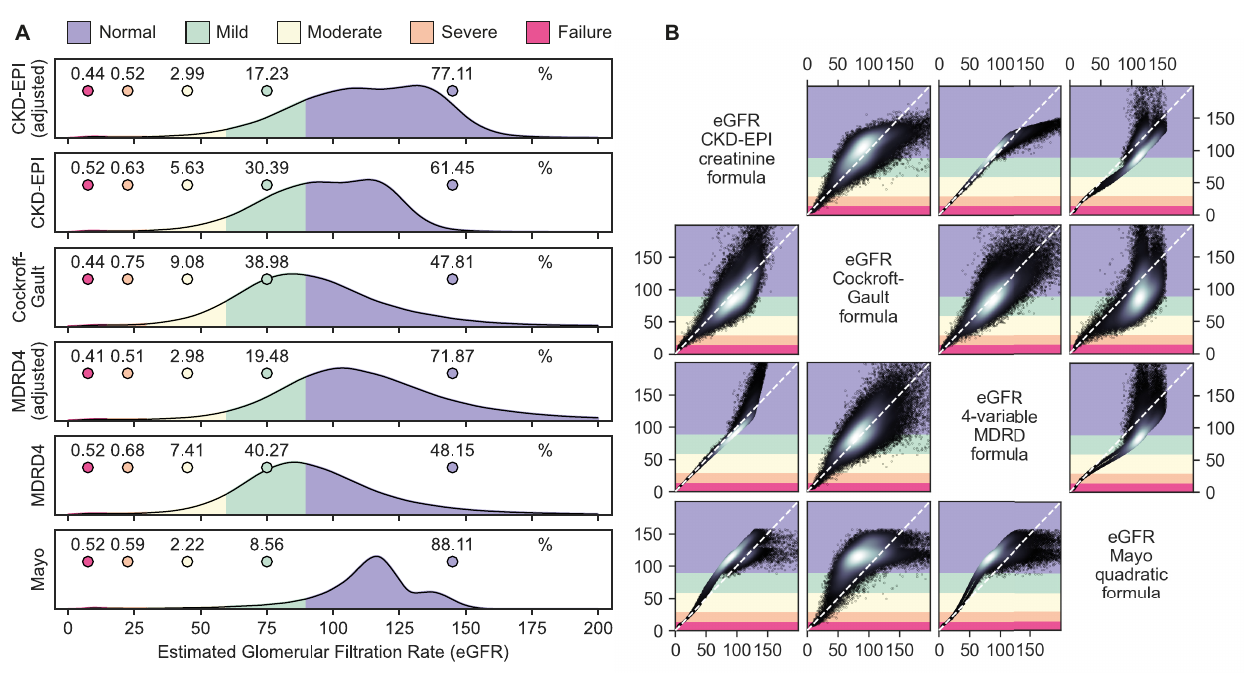
Fig 4. Sankey diagram unadjusted and adjusted categorization for the CKD-EPI formula.